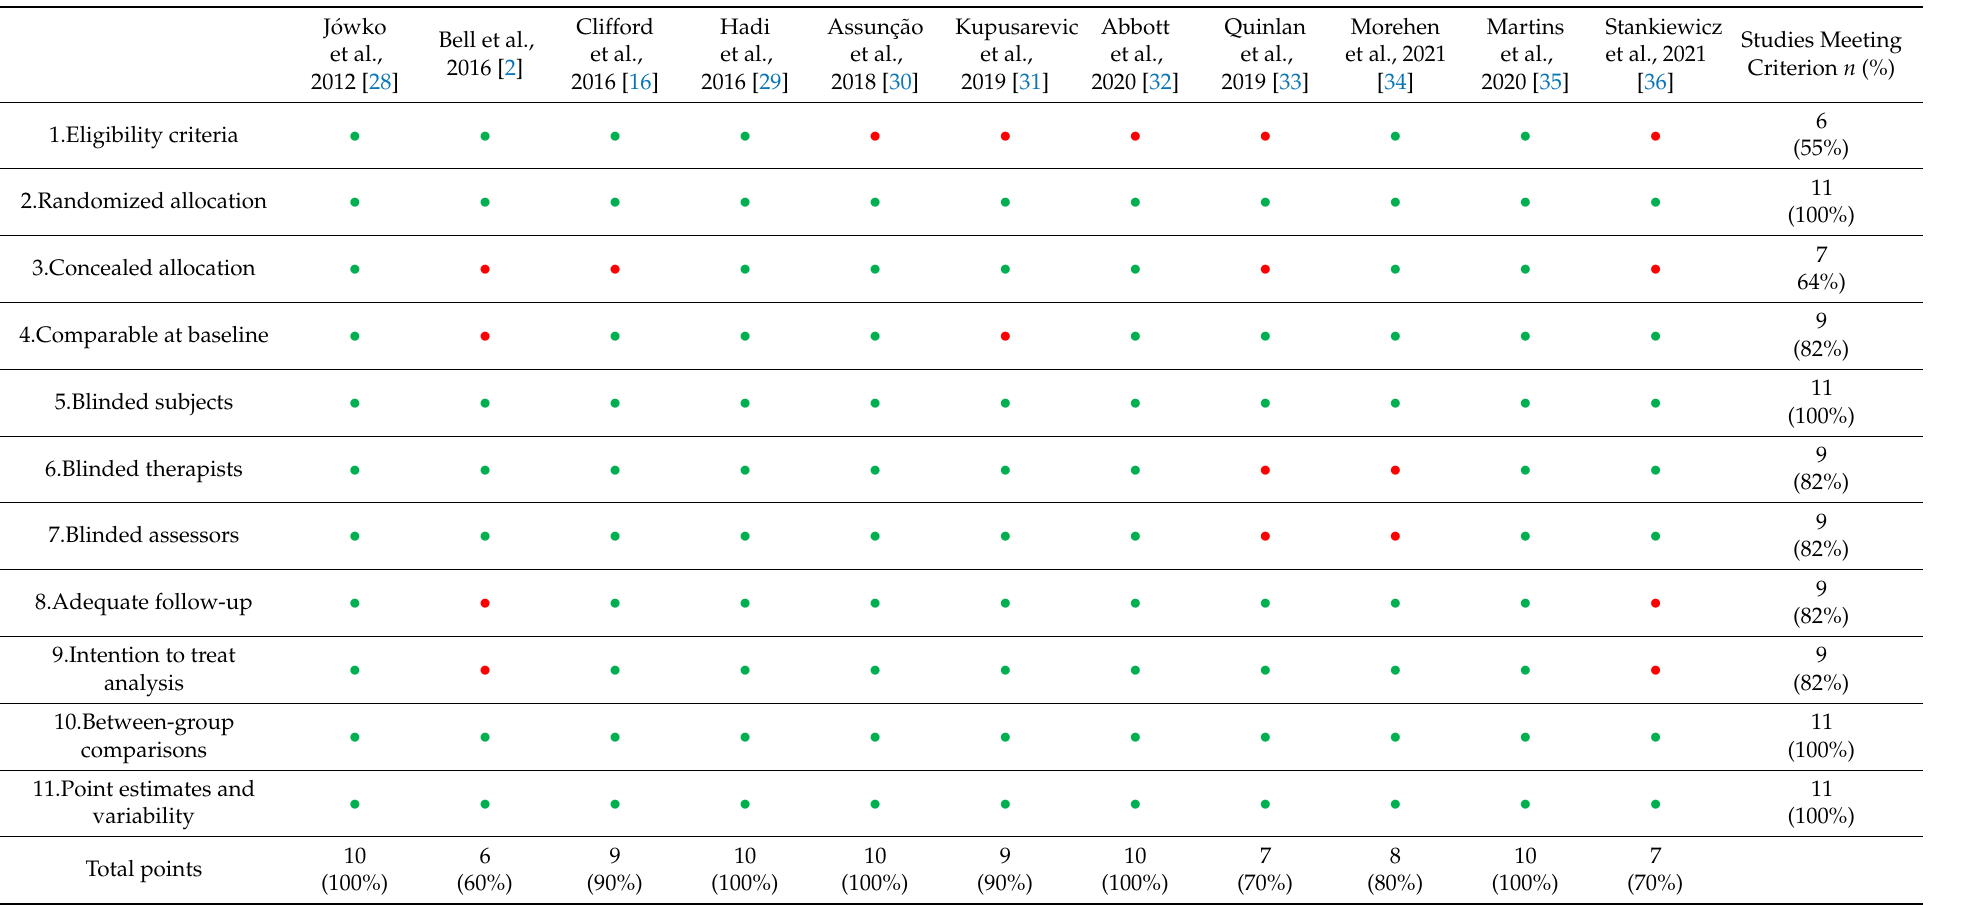
Table 2. Risk of bias graph: Review of authors’ judgment on each risk of bias item from PEDro scale presented as percentages across all included